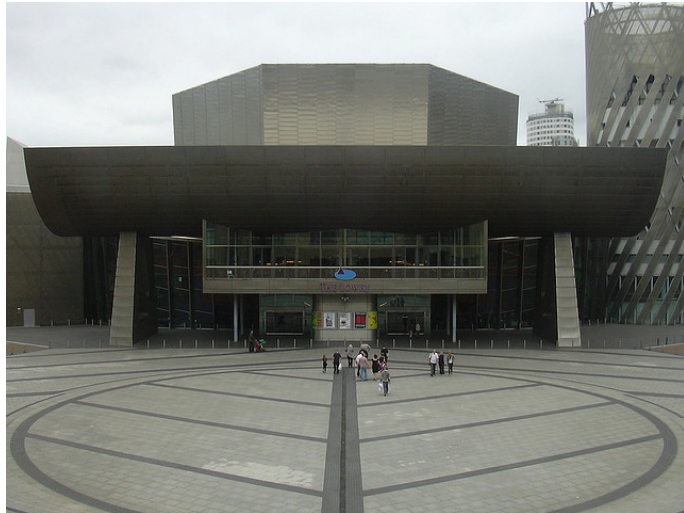
Figure 1. The Lowry, Salford. Source: CC-BY-NC-SA by